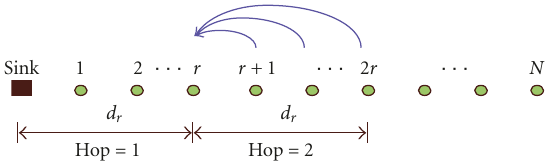
Figure 9: The lowest ETX parent selection scheme with MHR.